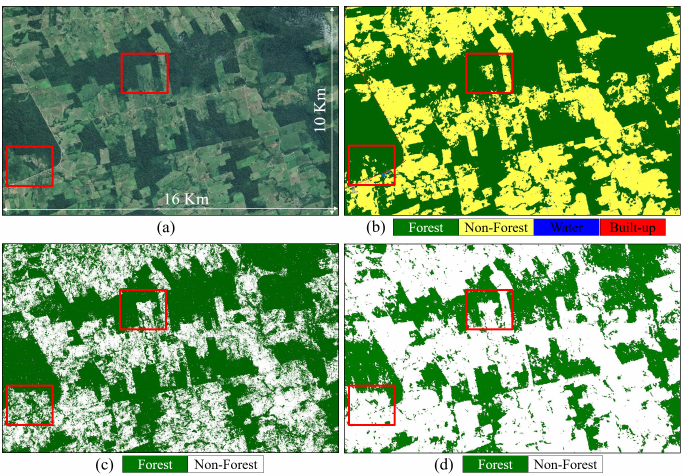
Figure 15. Example of high-resolution forest mapping with TanDEM-X at 12 m resolution. ( a )—Landsat image acquired on 6 June 2018 (centre scene coordinates (lat,lon): (3 ◦ 53 (cid:48) 42 (cid:48)(cid:48) S, 54 ◦ 45 (cid:48) 05 (cid:48)(cid:48) W). ( b )—Corresponding land cover map at 10 m resolution from the WorldCover 2020 product [9]. ( c , d )—TanDEM-X FNF maps at 12 m resolution obtained from an acquisition acquired on 28 May 2020, by applying the baseline clustering approach ( c ) and the proposed CNN ( d ). Red squares highlight some discrepancies among the different